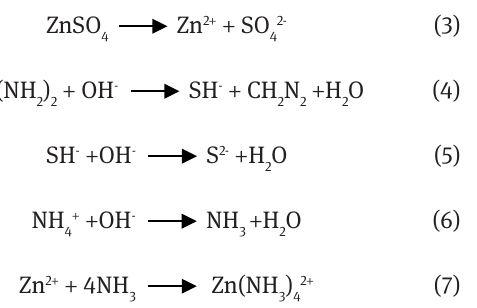
/C along with its elemental mapping and elemental 2